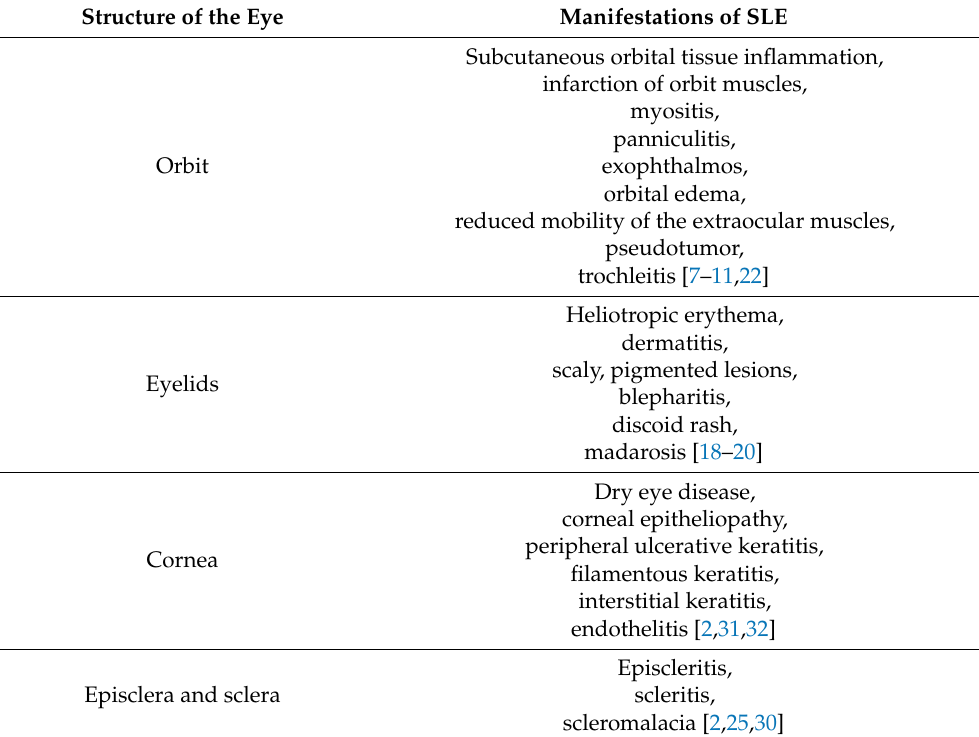
Table 1. Manifestations of SLE disease in individual structures of the